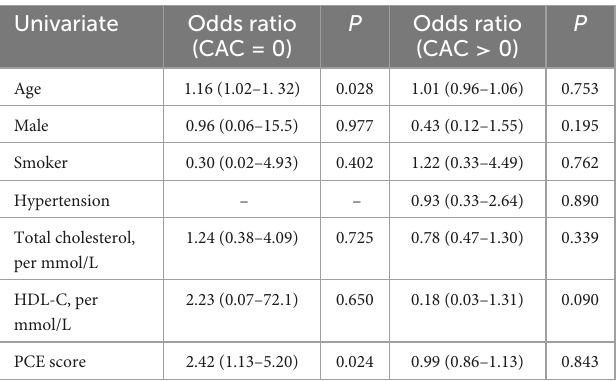
TABLE 3 Subgroup univariate analysis between CAC = 0 and CAC > 0 for CAC scores and various risk factors for MACE.